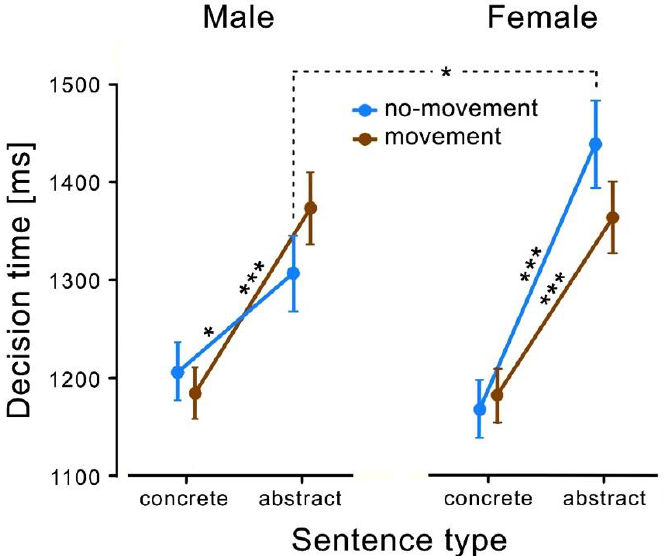
Figure 2. Decision times for all conditions separately for males and females. All children judged sentences with action verbs in concrete contexts significantly faster as plausible than in abstract contexts. In the abstract condition, males and females showed opposite effects. Males were significantly faster than females in the no-movement condition. Error bars display the standard errors of normalised data that are adjusted for repeated measures [46]. The results of the post-hoc Tukey tests are represented by asterisks (* = p < 0.05; *** = p < 0.001). Concerning the analysis of response errors, the 2 × 2 repeated measures ANOVA with gender as covariate showed a main effect of sentence (concrete vs. abstract) ( F (1, 58) = 9.608; p = 0.003) (Table 3). Post-hoc Tukey tests revealed that children made significantly more